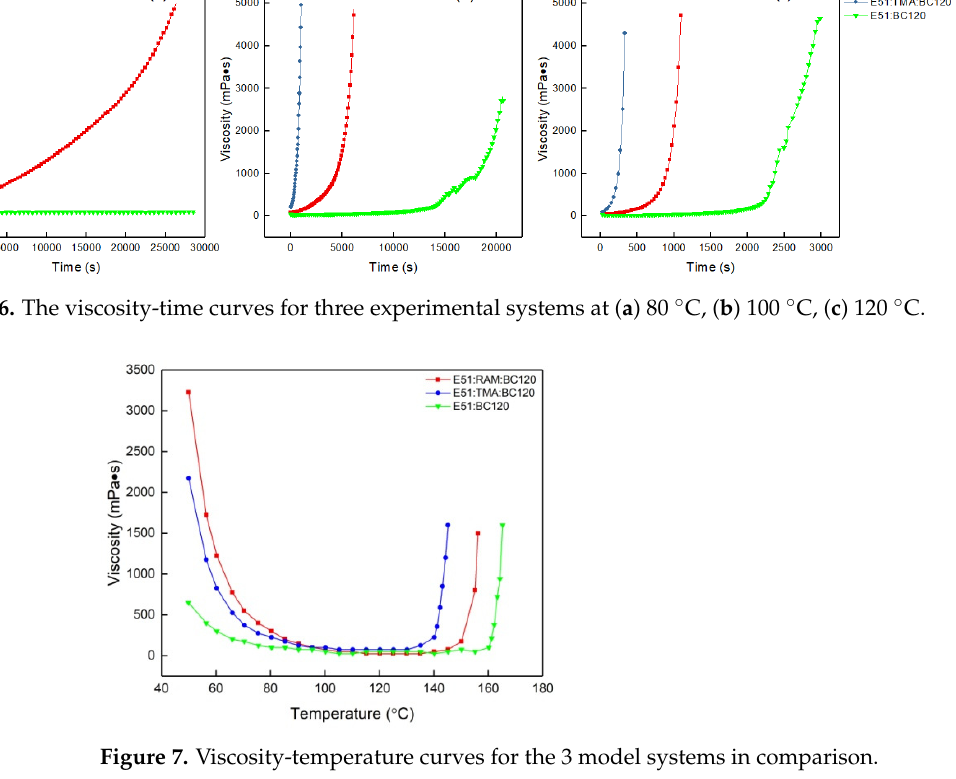
Aerospace 2021 , 8 , x FOR PEER REVIEW